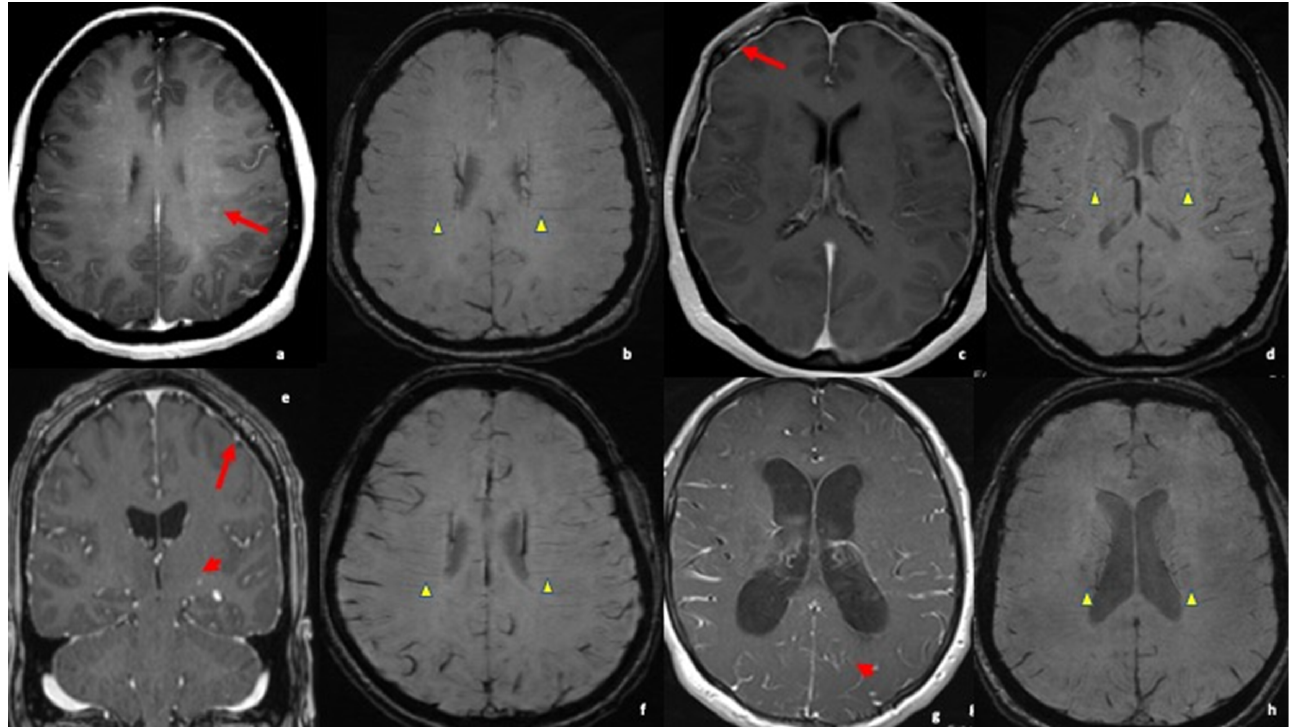
Figure 1. MRI axial ( a ) of the gadolinium-enhanced brain demonstrating perivascular enhancement throughout (red arrow); MRI brain ( b , d , f, h ) suspected weight images (SWI) show mildly dilated medullary veins perpendicular to long axis of lateral ventricles (yellow arrowhead); ( c ) gadolinium-enhanced MRI of the brain shows diffuse pachymeningeal enhancement (red arrow); ( e ) coronal and ( g ) axial cuts in post-gadolinium-enhanced MRI of the brain show leptomeningeal enhancement (red arrowhead) and pachymenigeal enhancement (red arrow).